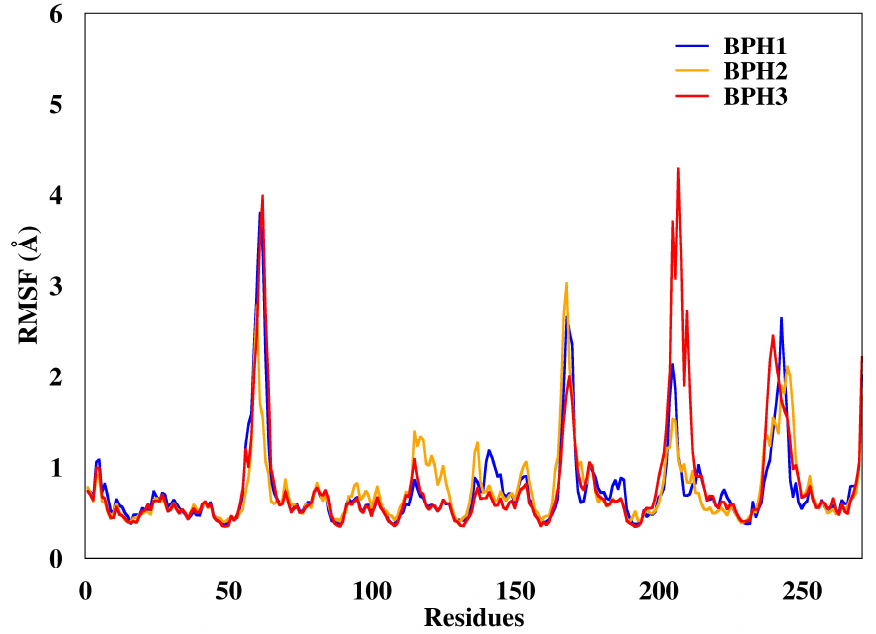
Figure 4. Root mean square deviations (RMSF) of the backbone atoms of the complexes from representative snapshots of MD simulations. Enzyme in the presence of the BPH1, BPH2, and BPH3 inhibitors are colored blue, yellow, and red, respectively.